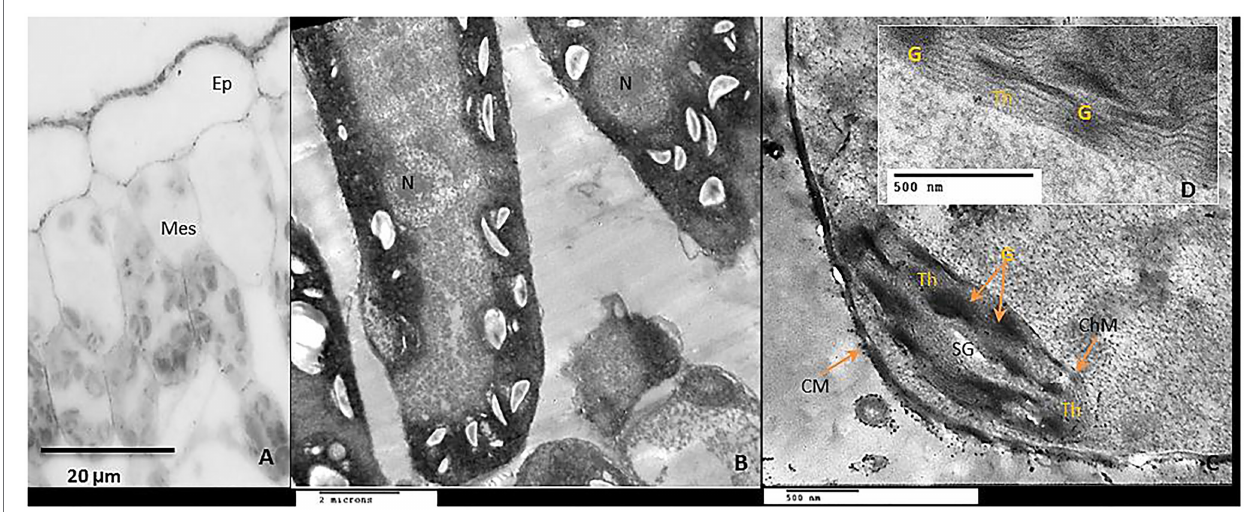
FIGURE 11 | Anatomical structure of Tomato leaf cv “Super marmende”growing under stress chilling conditions 5 days/4ºC for 6 h/day treated with GABA at 2 mM. (A) Leaf cross-section showed the upper epidermis (Ep) and the two mesophyll layers (Mes); note that chloroplasts were accumulated together in clusters. (B) TEM micrograph showed mesophyll ultra-structures: There are expansions in the size of the plastids due to the large starch grains in them, but with a tendency to elongate shape. (C,D) high magnification of one chloroplast showed normal chloroplast membrane (ChM), well-developed grana (G), and stromal thylakoids (Th), the cell wall (CW) was attached well with the outer cellular